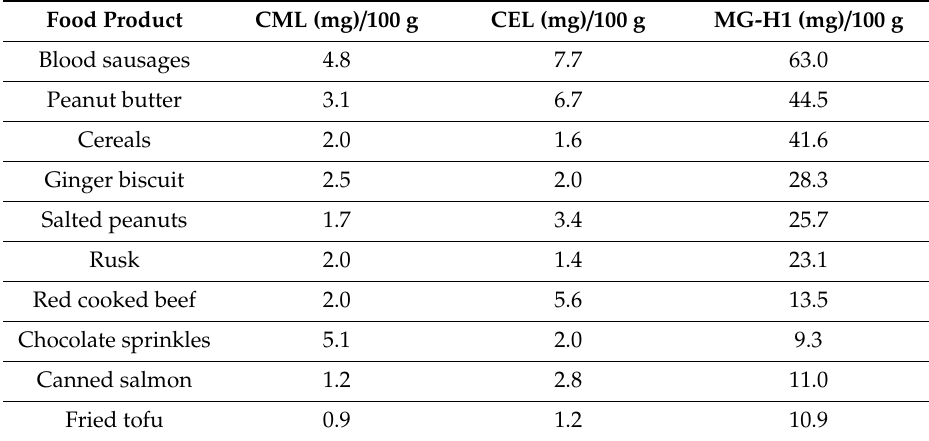
Table 2. Average N ε -carboxymethyl-lysine (CML), N ε -carboxyethyl-lysine (CEL), and methylglyoxal-derived hydroimidazolone-1 (MG-H1) content of several food products as published by Scheijen et al. (2016) [147]. Food